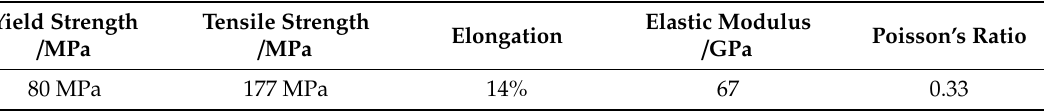
Table 2. Mechanical properties of AA 5754 H111